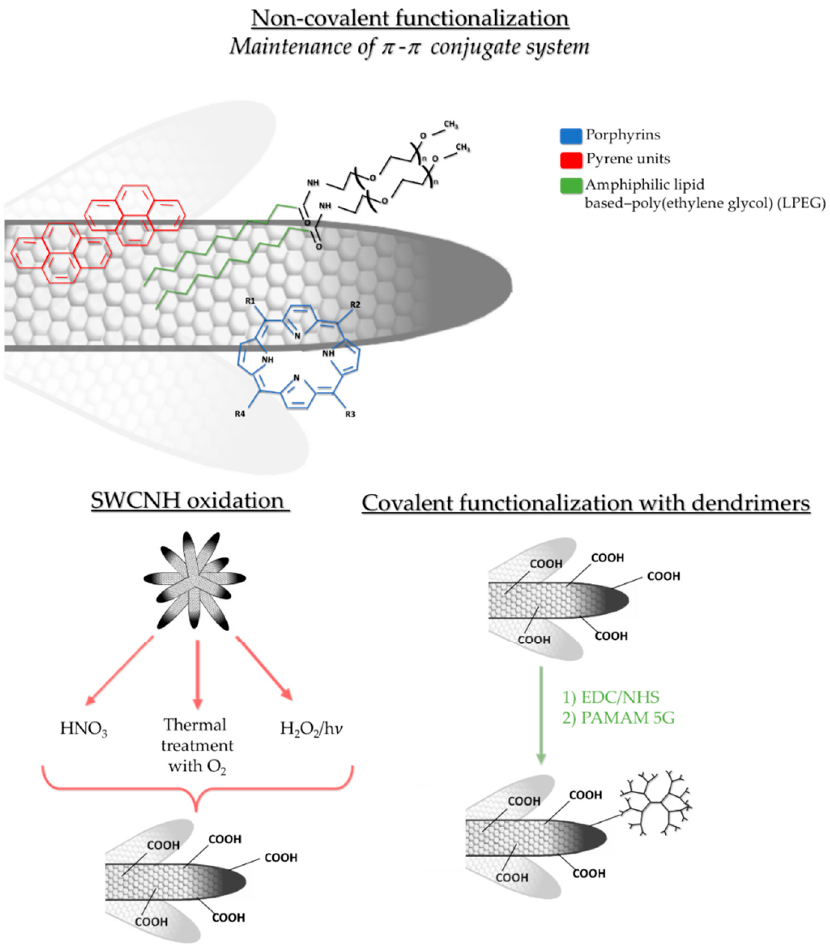
Figure 2. Non-covalent and covalent functionalization of SWCNH. Different types of non-covalent functionalization with porphyrins, pyrene units and amphiphilic lipid-based poly(ethylene glycol). Schematic oxidation for carboxylic group formation and covalent functionalization with fifth generation poly(amidoamine) (PAMAM) dendrimer.